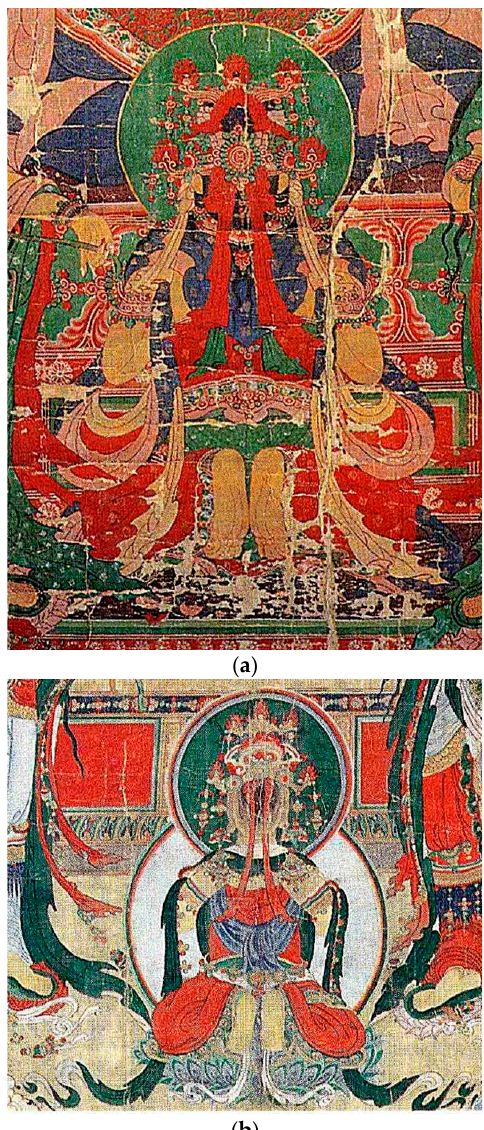
Figure 11. The Listener iconography in ( a ) the Sakyamuni Preaching from Bosalsa Temple; ( b ) Assembly of the Trikaya from Gapsa Temple. Arranged by the author.